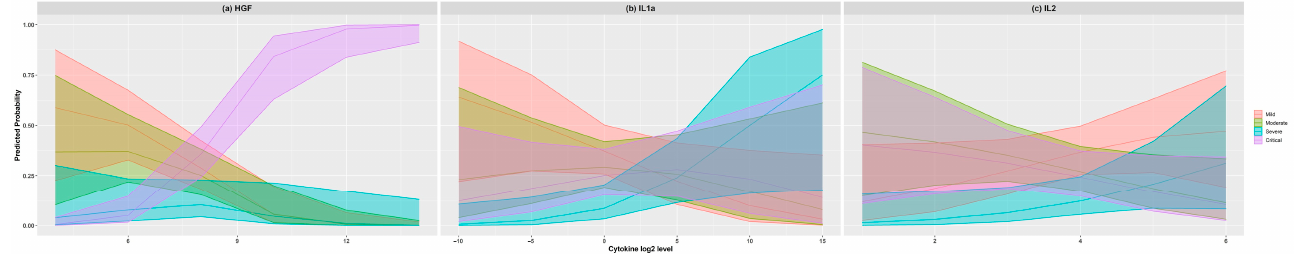
Figure 2. Effect plots of the estimated probabilities of belonging to each severity group according to the level of HGF ( a ), IL-1 α ( b ), and IL-27 ( c ). The log2 level of each cytokine is measured in pg/mL.